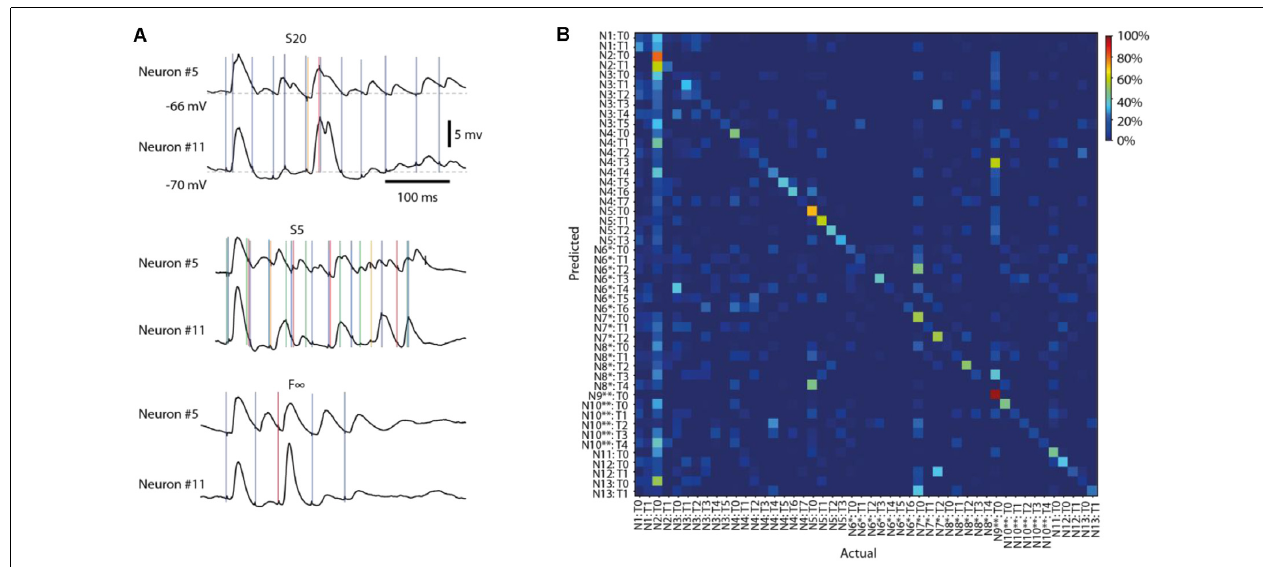
FIGURE 4 | Different response types evoked by the same stimulation pattern in different neurons. (A) Averages of intracellular responses of neuron #5 ( N = 100 responses) and neuron #11 ( N = 80 responses) to stimulation pattern S20 (top). Vertical colored lines indicate the individual stimulation pulses of that stimulation pattern. Similar display for the average responses to two other input patterns (middle, bottom). The responses of Neuron #5 to pattern S5 are also illustrated in Figures 2A,B , 3A . (B) Confusion matrix for all response types identified for all neurons for stimulation pattern F ∞ . Neurons (N#) recorded in the same experiments are indicated by * and **, respectively. T# indicates the response